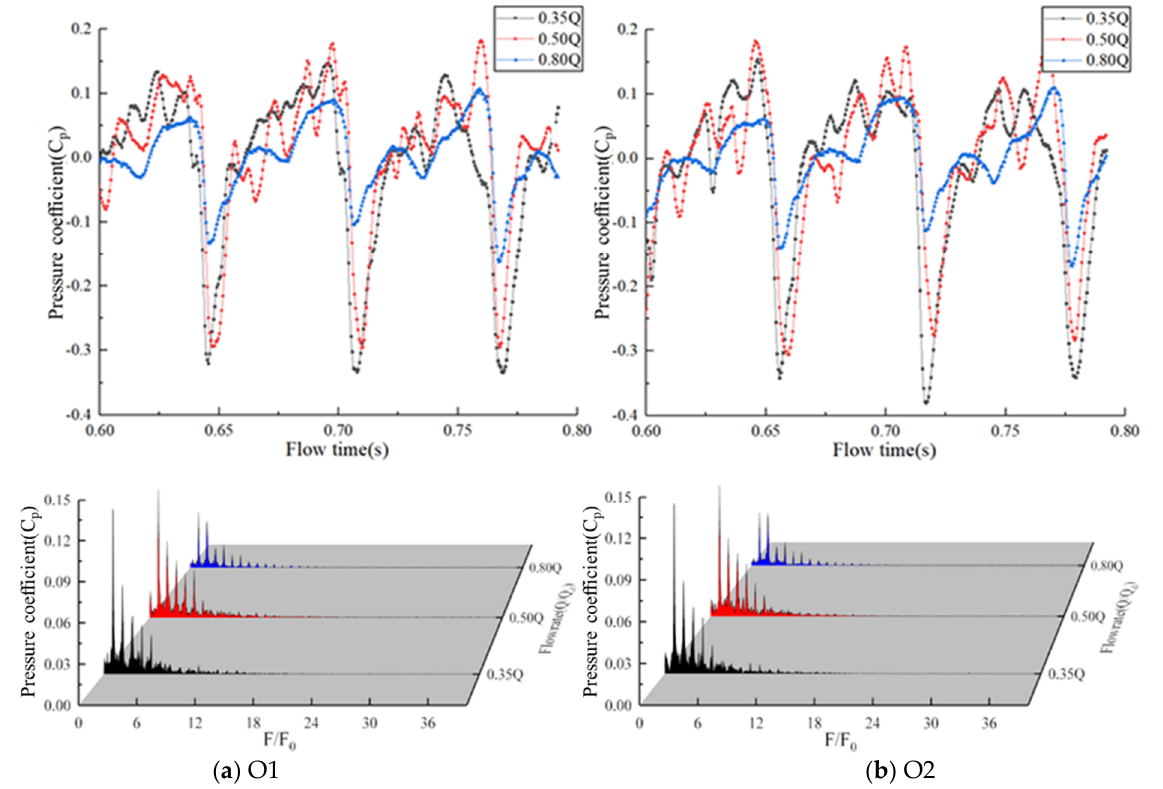
Figure 16. Pressure pulsation of scheme A (